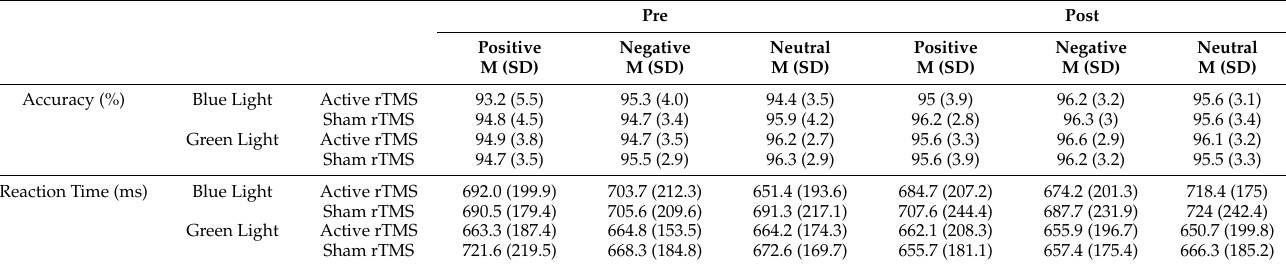
Figure 2. Valence-specific accuracy differences (post minus pre) in the EMOBACK task from baseline under blue and green light exposure after ( a ) active and ( b ) sham rTMS application over the right DLPFC. * p < 0.05). Table 2. EMOBACK task performance separated for emotion conditions (positive, negative, neutral) at baseline (pre) and after stimulation (post).